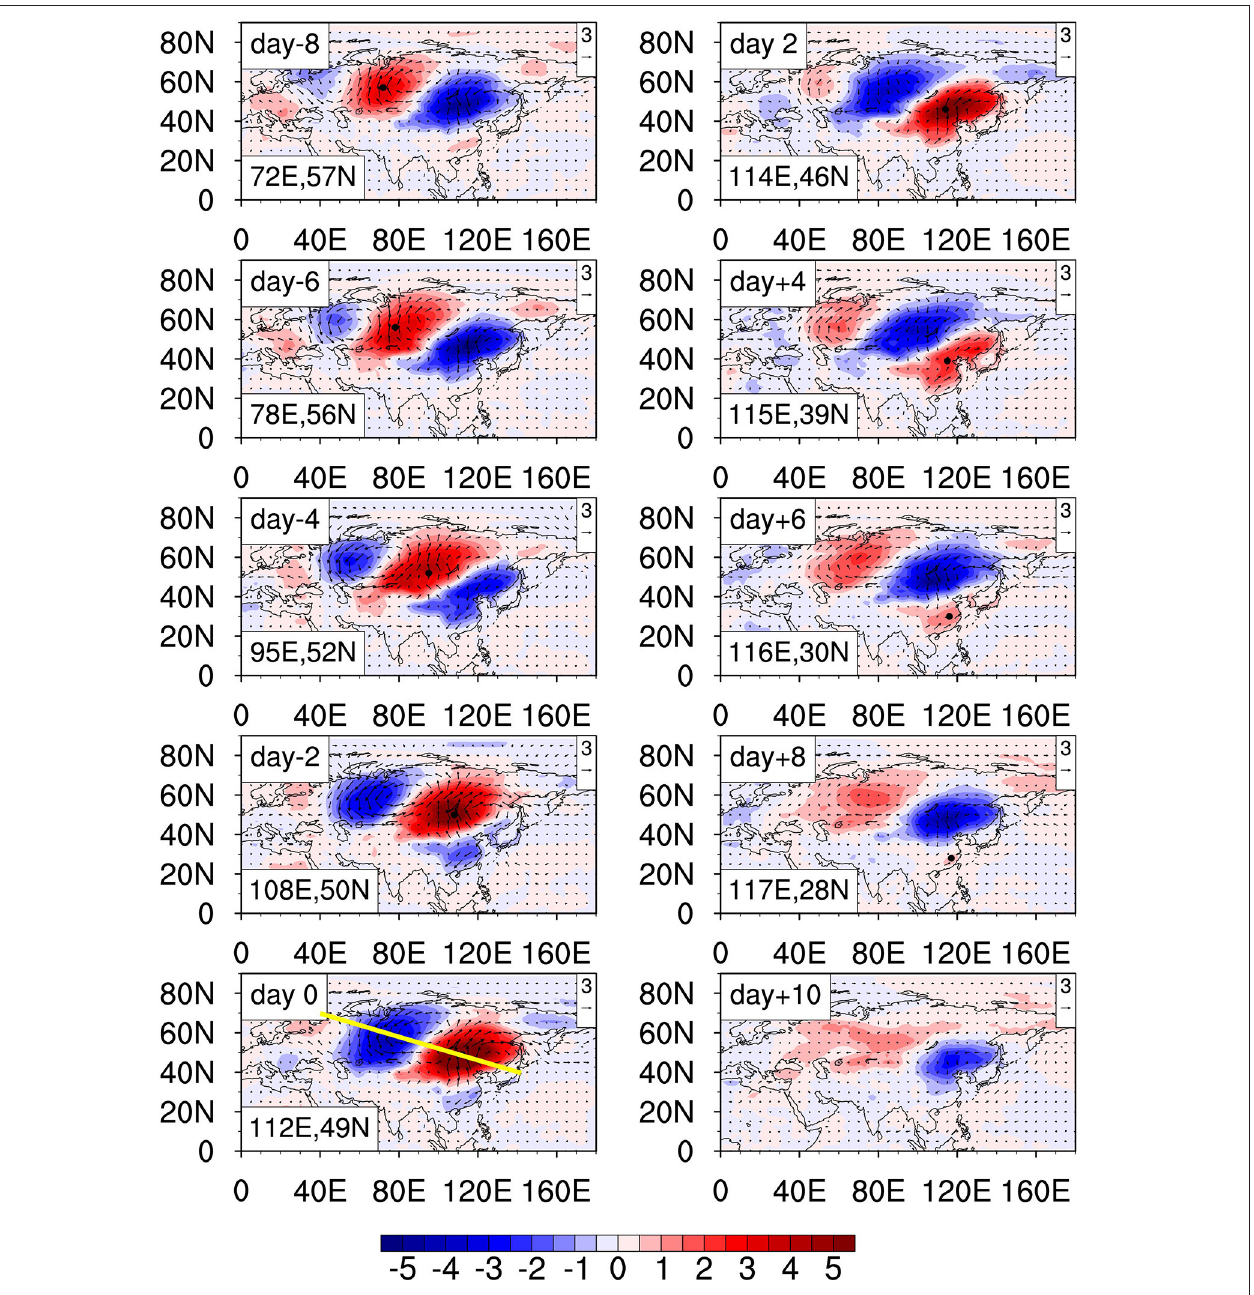
FIGURE 4 | Evolution of the composite 10–30-day filtered air temperature at 2m (shading, unit: K) and wind at 850 hPa (vector, unit: m s − 1 ) from day − 8 to day + 10, with an interval of 2 days. The black dots represent the center of the maximum positive temperature anomalies associated with the southeastward propagation. The latitudinal and longitudinal values of the dots are shown at the left bottom corner of each panel. The yellow line is determined by a point (70 ◦ N, 40 ◦ E) and another point (40 ◦ N, 140 ◦ E).